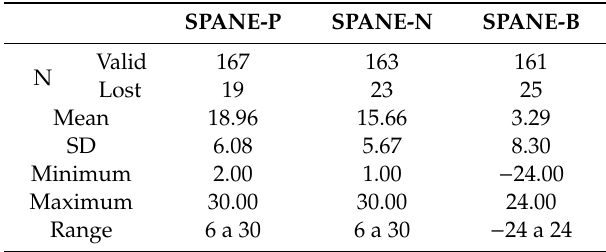
Table 2. Main descriptive data of